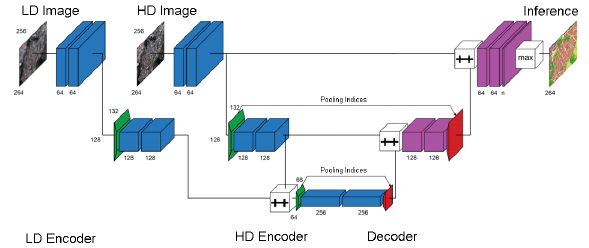
Figure 2. Proposed architecture for fusion. Same color legend as figure